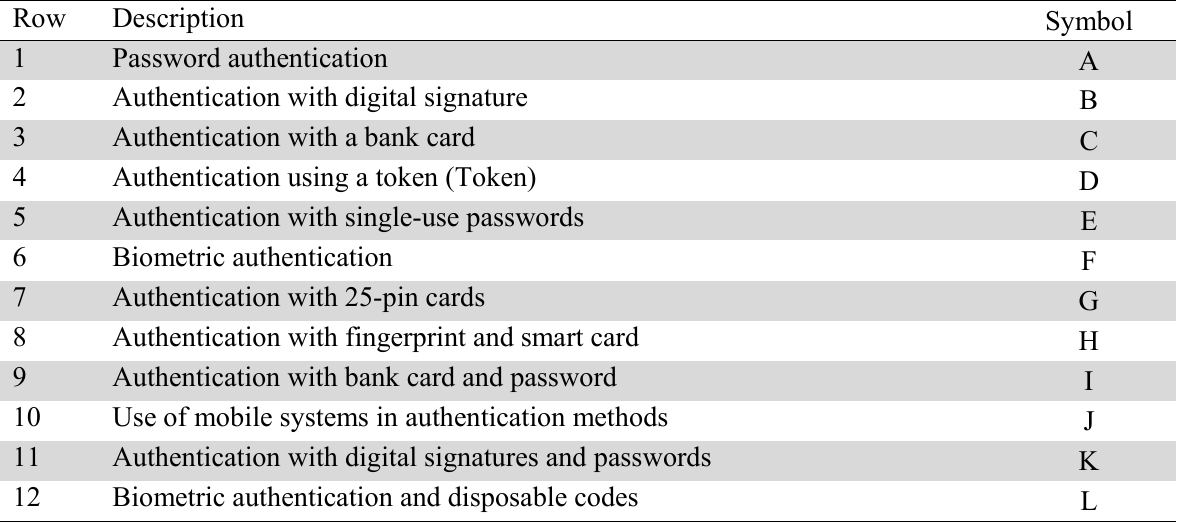
The summary of factors authenticating transactions for online banking at Parsian Bank